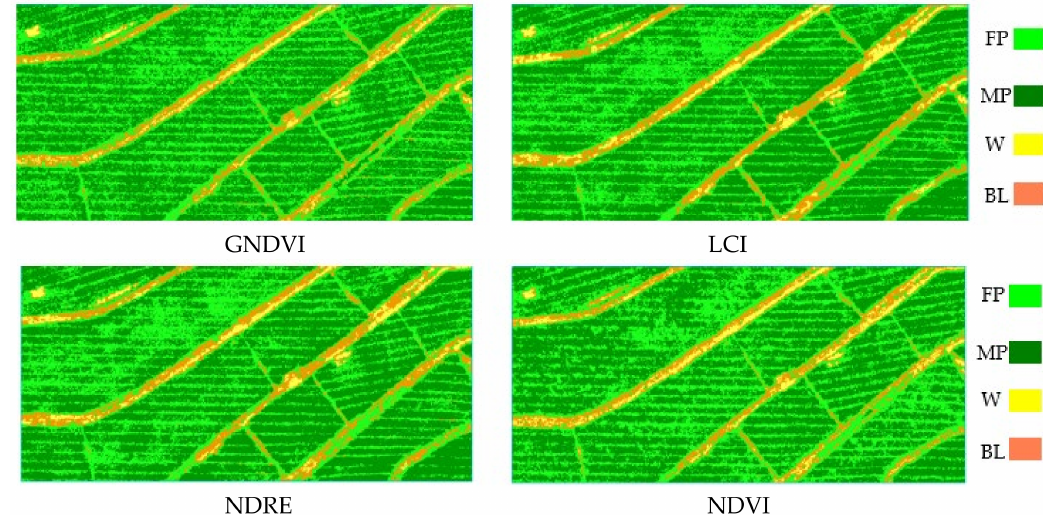
Figure 8. Object-oriented classification results for the visible light vegetation index. FP: Female parent; MP: Male parent; W: Weed; BL: Bare land.